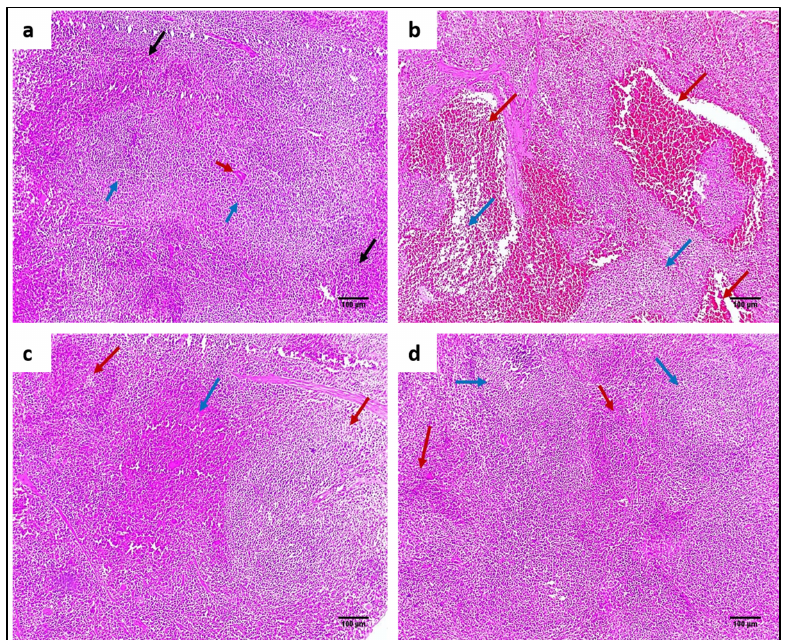
Figure 9. H&E micrographs of spleen sections of ( a ) normal spleen showing normal-sized white pulp (lymphoid follicles) (blue arrows) with central arteriole (red arrow) surrounded by average-sized red pulp (blood sinusoids) (black arrows) ( × 100). ( b ) Group I showed marked congestion exhibiting dilated congested red pulp and areas of hemorrhage (red arrows) with atrophic white pulp (blue arrows) ( × 100). ( c ) Group II showed mild congestion in the red pulp (blue arrow) with average-sized lymphoid follicles (red arrows) ( × 100). ( d ) Group III showed preserved white pulp (lymphoid follicles) (blue arrows) with average-sized red pulp (red arrows) ( × 100). Pharmaceuticals 2022 , 15 , x FOR PEER REVIEW